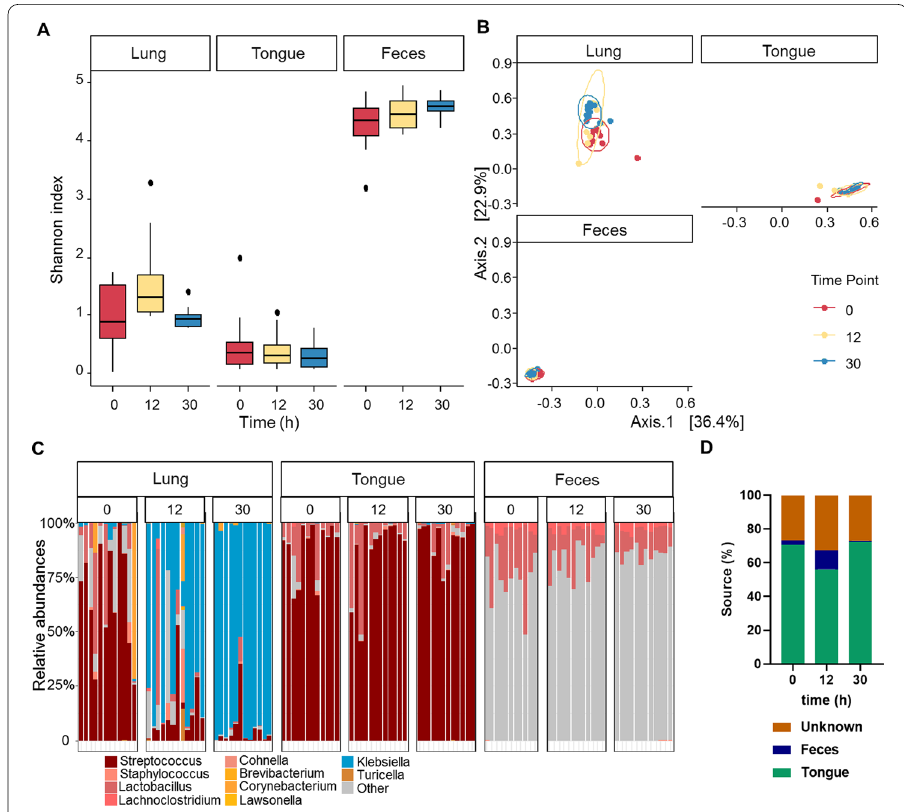
Fig. 3 Alpha and beta diversity of the lung, tongue and fecal microbiotas. Mice received an intranasal inoculation with 10 4 colony forming units (CFU) of K. pneumoniae . Mice were killed at 0, 12, and 30 h post-inoculation (n 12), lung tongue and feces were extracted for microbiota analysis. a Alpha diversity; = Shannon of lung tongue and fecal samples at 0, 12 and 30 h post-inoculation. b Beta diversity; PCoA Bray analysis of lung tongue and feces over time. c Genus distribution for lung tongue and fecal microbiota at 0, 12, 30 h post-inoculation, where the top 10 genera in the lung are colored, other genera are grey. d Fast expectation–maximization for microbial source tracking (FEAST) analysis on the lung microbiota showing which percentage of the lung microbiota can be traced back to the tongue, feces and unknown source at 0, 12 and 30 h post-inoculation, in a dataset without K.